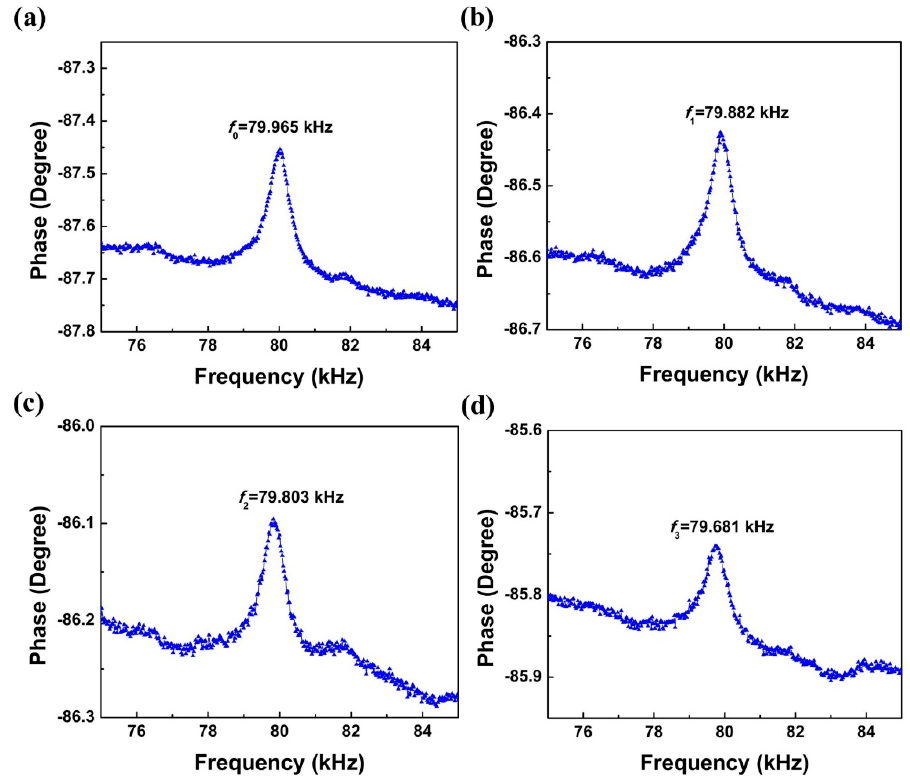
Figure 5. Resonant frequencies for different mass loaded: ( a ) no mass loaded; ( b ) 0.1 μ g total mass loaded; ( c ) 0.2 μ g total mass loaded and ( d ) 0.3 μ g total mass loaded.